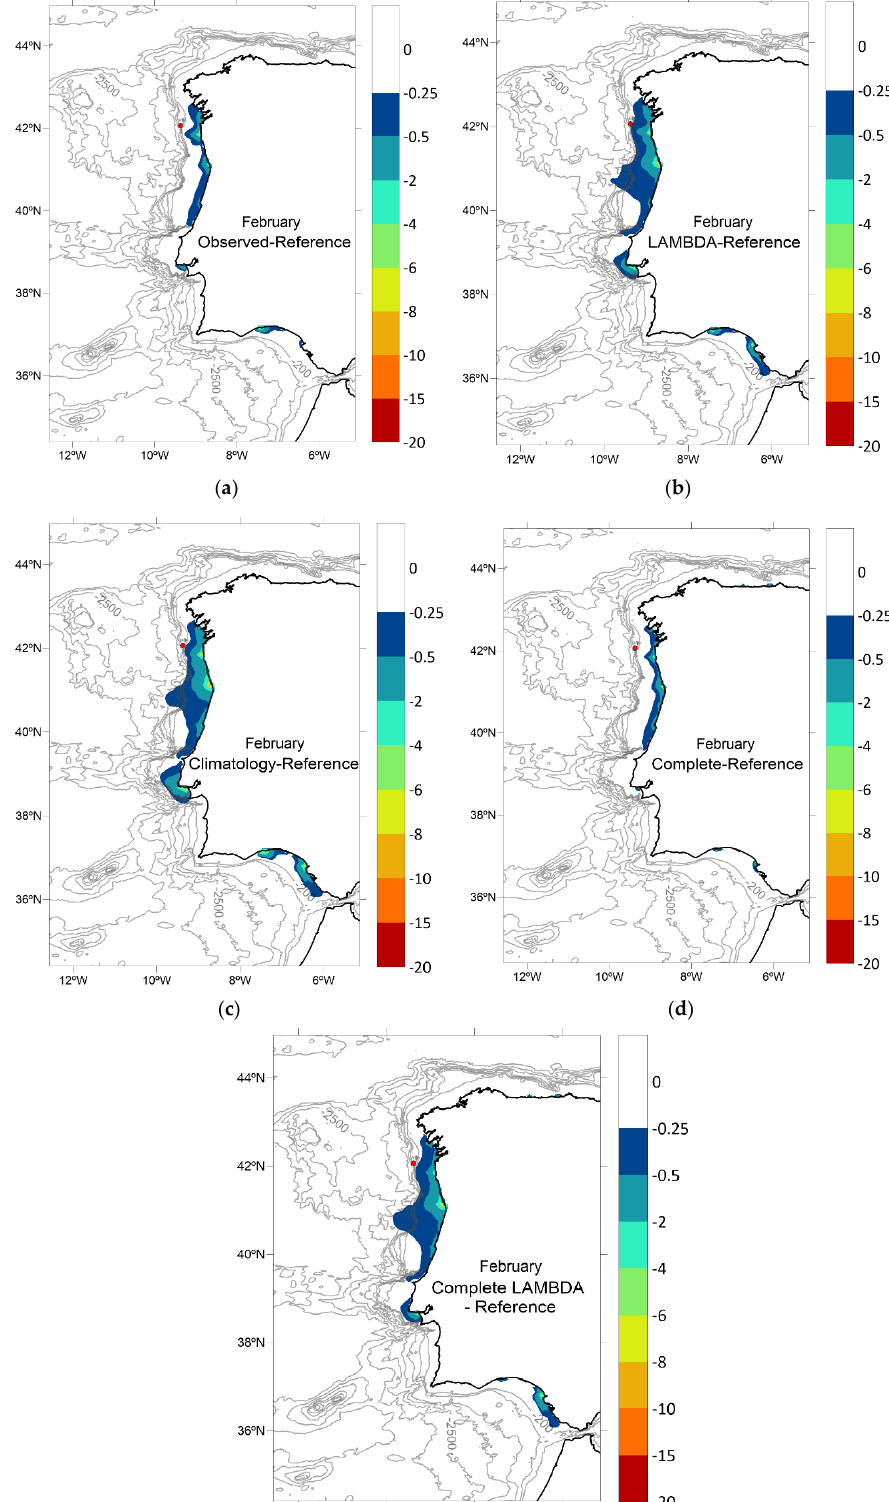
Figure 12. Surface salinity difference during February 2018 between the reference scenario with each LAMBDA land boundary scenarios ( a ) Observed; ( b ) LAMBDA; ( c ) Climatology; ( d ) Complete Observations; ( e ) Complete LAMBDA. Salinity difference between 0 and − 0.5 is not represented.